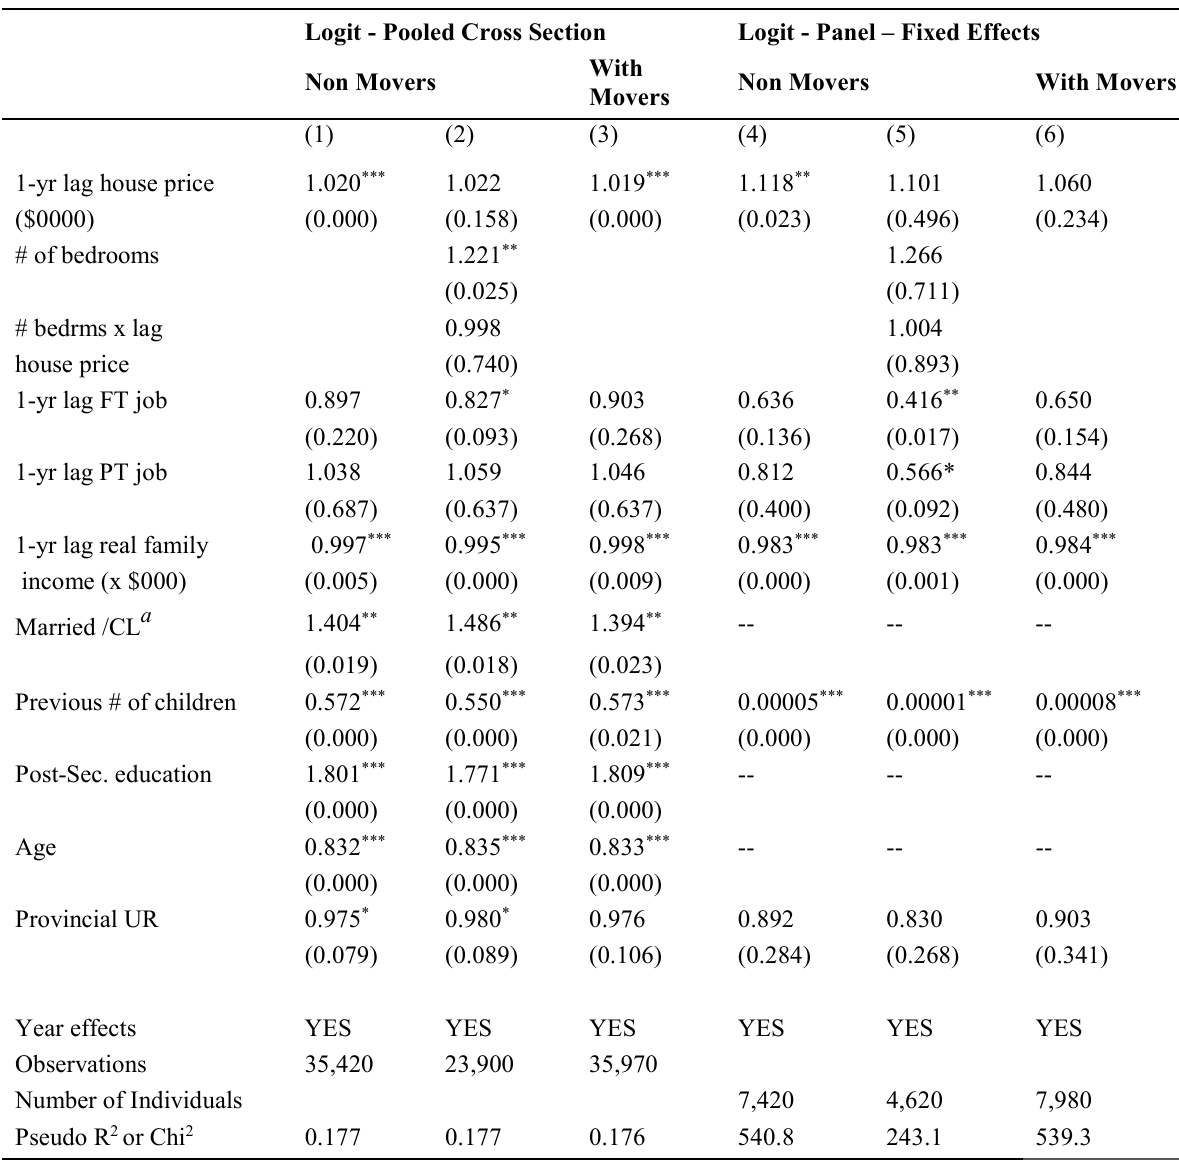
Table 2: Effect of house prices on marginal fertility of owners (proportional effect on odds ratios, p-values in